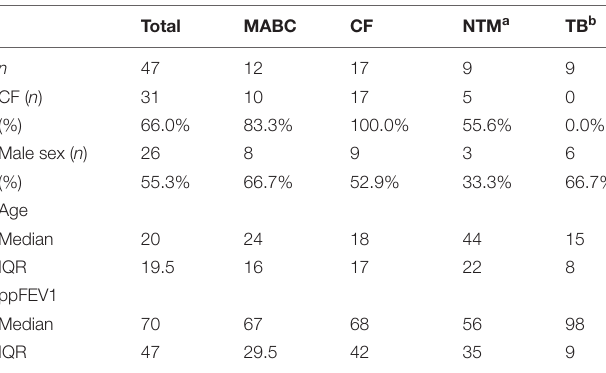
TABLE 1 | Characteristics of study subjects in total and divided by study groups are shown.